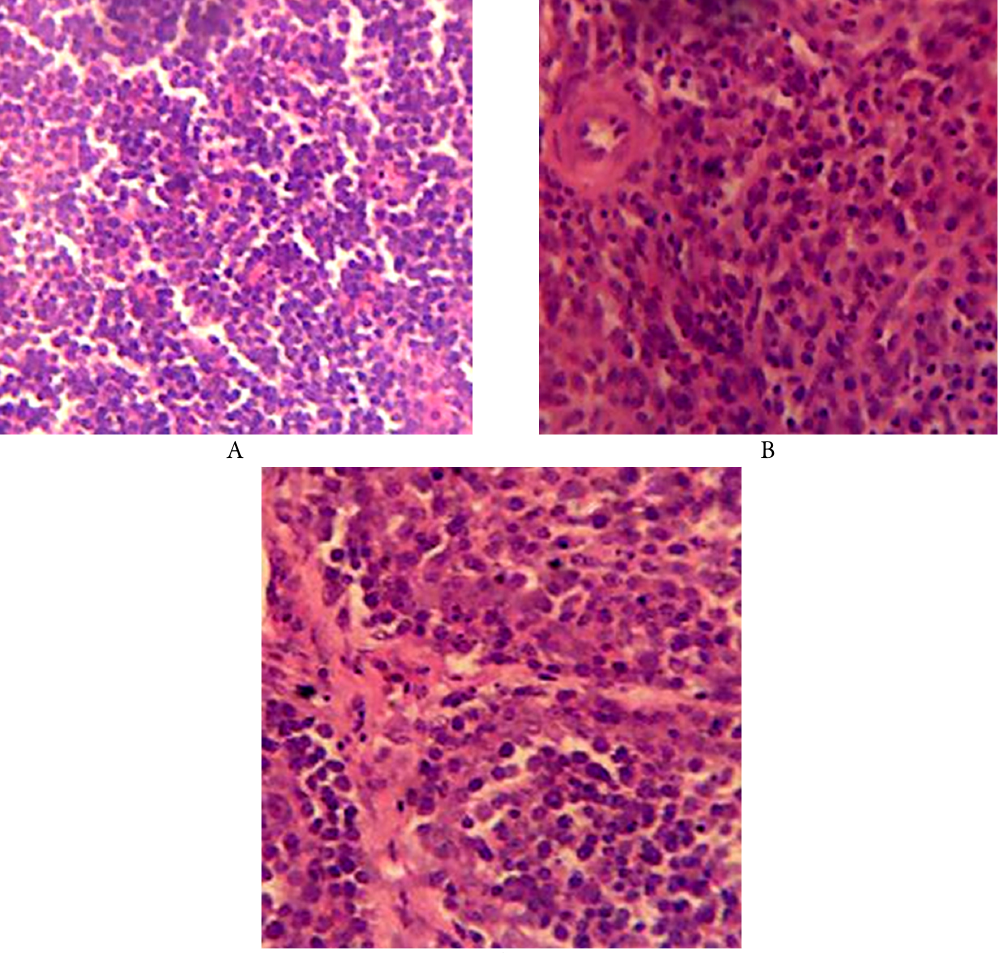
Figure 1. A. H & E thymus section from cockerels exposed to the high dose of root extract of Anacardium occidentale showing no obvious pathological change. Magnification H&E X400; B. H & E spleen section from cockerels exposed to the high dose of root extract of Anacardium occidentale . showing no obvious pathological change. Magnification H&E X400; C: H & E Bursa of Fabricius section from cockerels exposed to the high dose of root extract of Anacardium occidentale showing no obvious pathological changes with normal distribution of lymphocytes. Magnification H&E